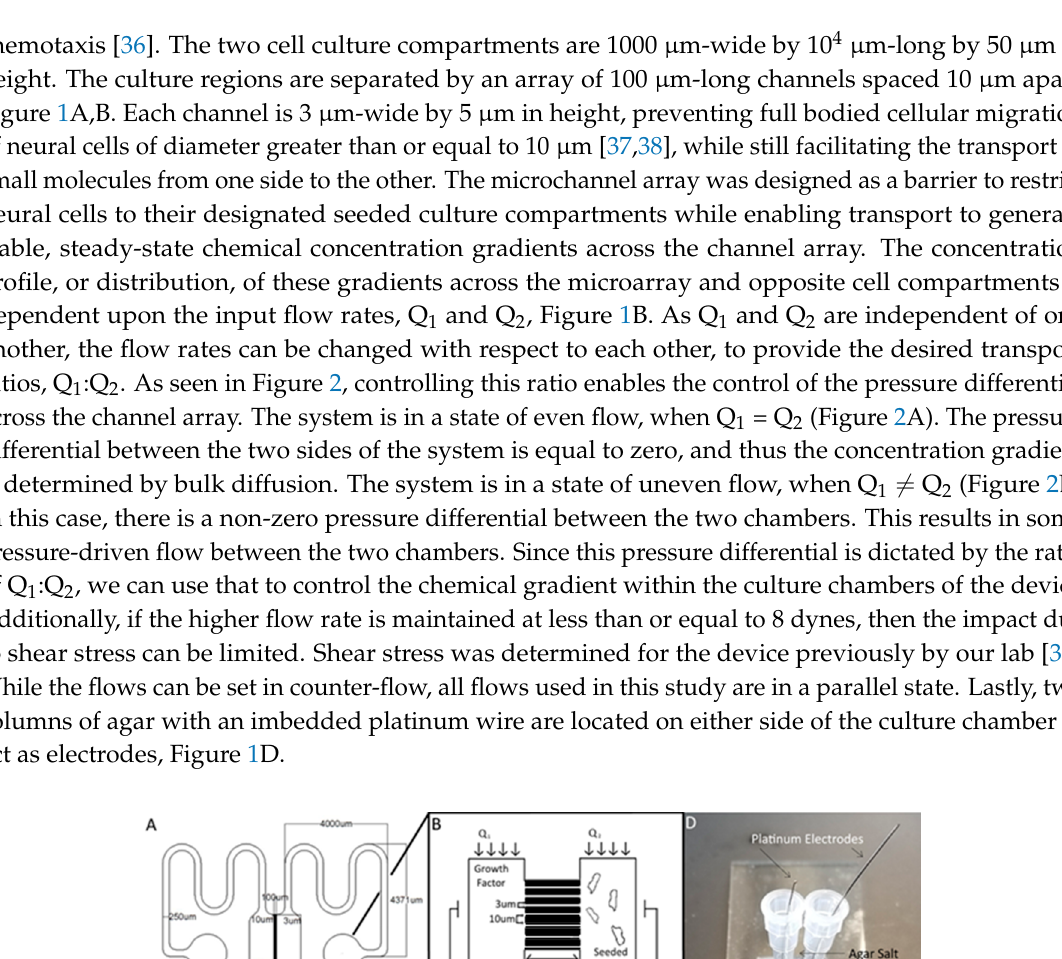
to enable controlled concurrent electrical stimulation. ( C ) Image of the device (without electrodes) showing fluid flow within culture chambers. ( D ) Image of device demonstrating electrode placement and